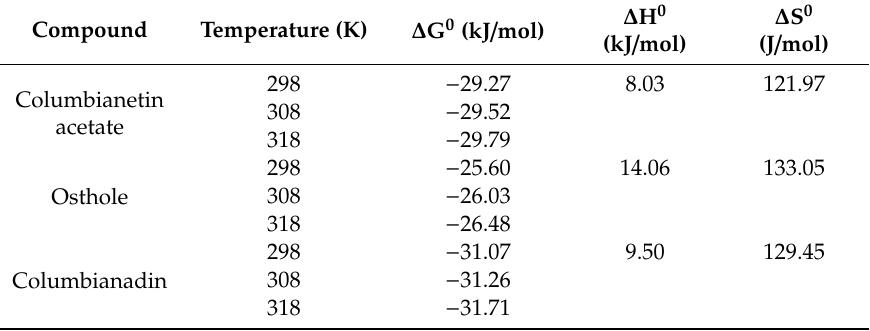
Table 4. Thermodynamics Equation parameters for three coumarins on HP-20 resin at di ff erent temperature.